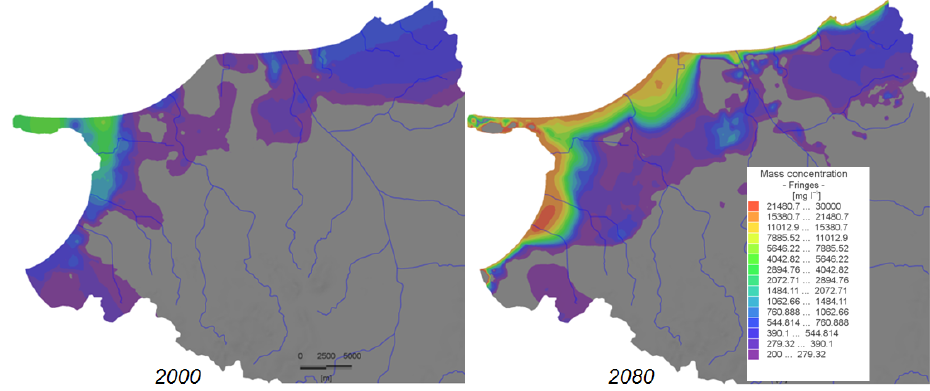
Figure 4. Saltwater intrusion at the start of simulations (year 2000) and after 80